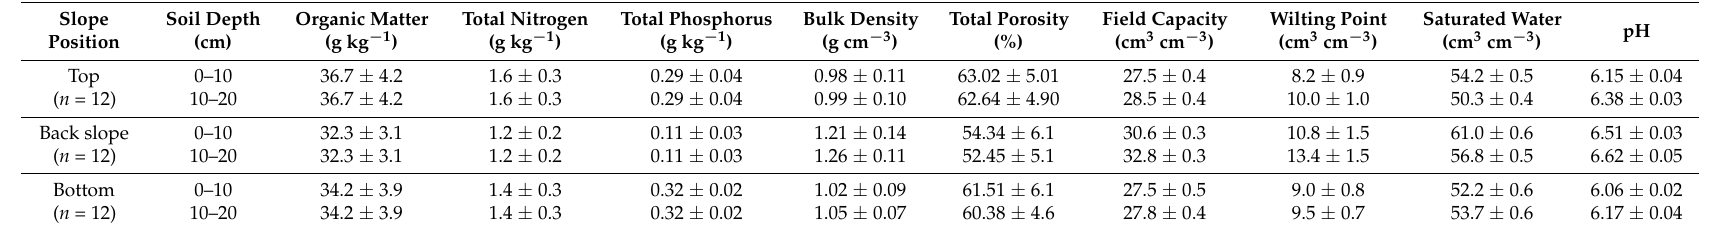
Table 1. Soil physicochemical properties before planting in the experimental